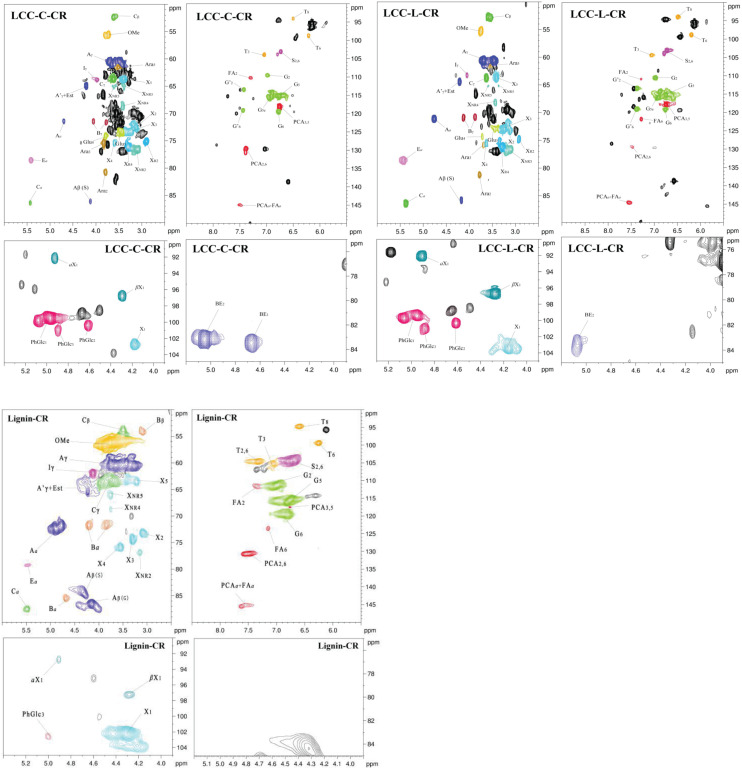
2D-HSQC NMR spectra of LCC-C-CR, LCC-L-CR, and Lignin-CR samples.